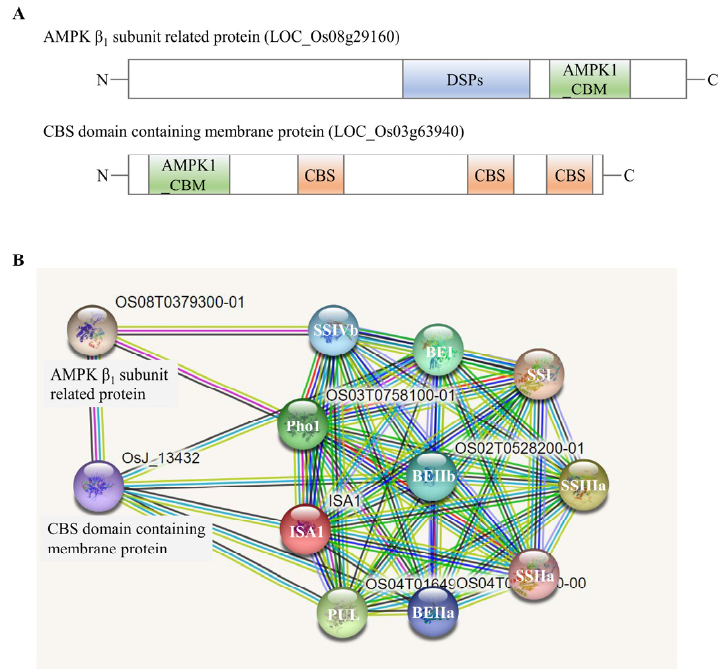
Figure 6. Two protein kinases identified by LC-MS/MS: ( A ) Structure of two protein kinases. ( B ) Potential association networks of two protein kinases and starch synthesis enzymes in rice endosperm from STRING, a database of known and predicted protein interactions. Displayed here is the evidence view, where different line colors represent the types of evidence for the association.